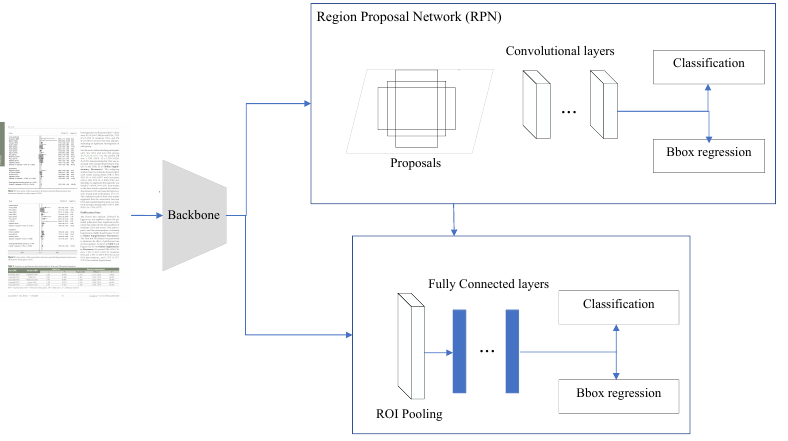
Figure 3. The structure of Faster R-CNN. The workflow consists of feeding the input image to CNN network. Afterwards, potential object regions are found with the RPN. The final step is ROI pooling that extract features for each region and feed them to classifier and the bbox regressor.